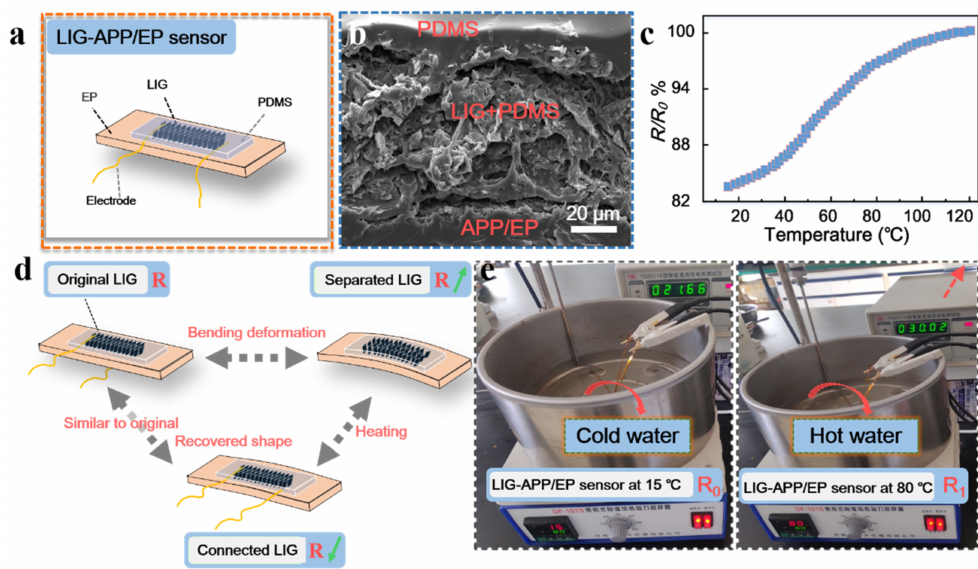
Figure 6. Performance and structure of the LIG sensors. ( a ) Structure of the LIG sensors. LIG and APP/EP were packaged together with a solvent based on polydimethylsiloxane (PDMS). ( b ) SEM image illustrating the cross-section of the LIG sensors. ( c ) The resistance–temperature curve between 20–120 ◦ C. ( d ) Working mechanism of the LIG-APP/EP sensors for temperature detection based on the shape memory of the EP composite. ( e ) Illustration of the water-resistant LIG-APP/EP sensor for detecting changes in